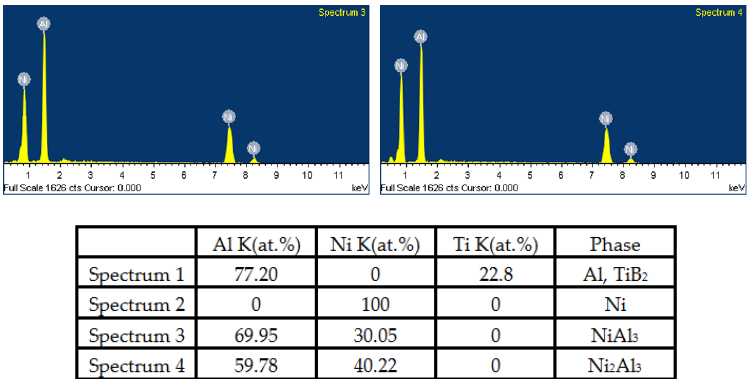
Figure 11. Cross-sectional morphologies and compositions of Ni / Al-TiB 2 coatings as-sprayed at 450 ◦ C and after annealing at 650 ◦ C for 10 h: ( a ) 200 × , and ( b ) 500 × .